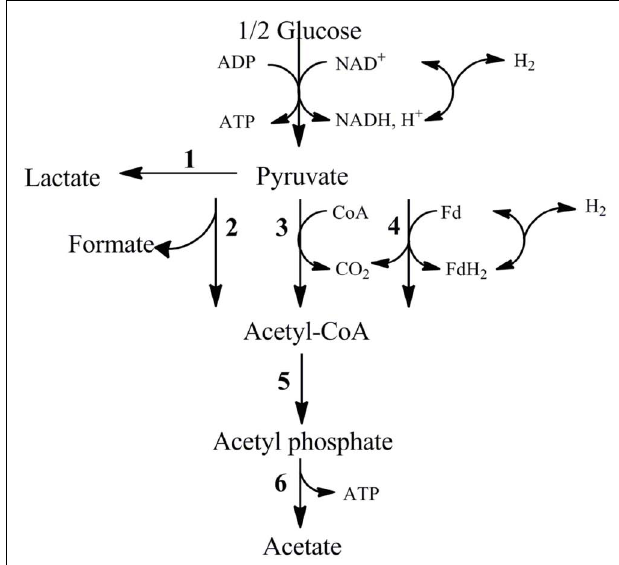
FIGURE 6 | Pathways for the metabolism of pyruvate by H. hydrogeniformans based the genome annotation. (1) Lactate dehydrogenase (Halsa_1287), (2) Pyruvate formate lyase (Halsa_0723), (3) Pyruvate dehydrogenase (Halsa_0919, Halsa_2297, Halsa_0164), (4) Pyruvate ferrodoxin/flavodoxin oxidoreductase (Halsa_2334), (5) Phosphotransacetylase (Halsa_1556), (6) Acetate kinase